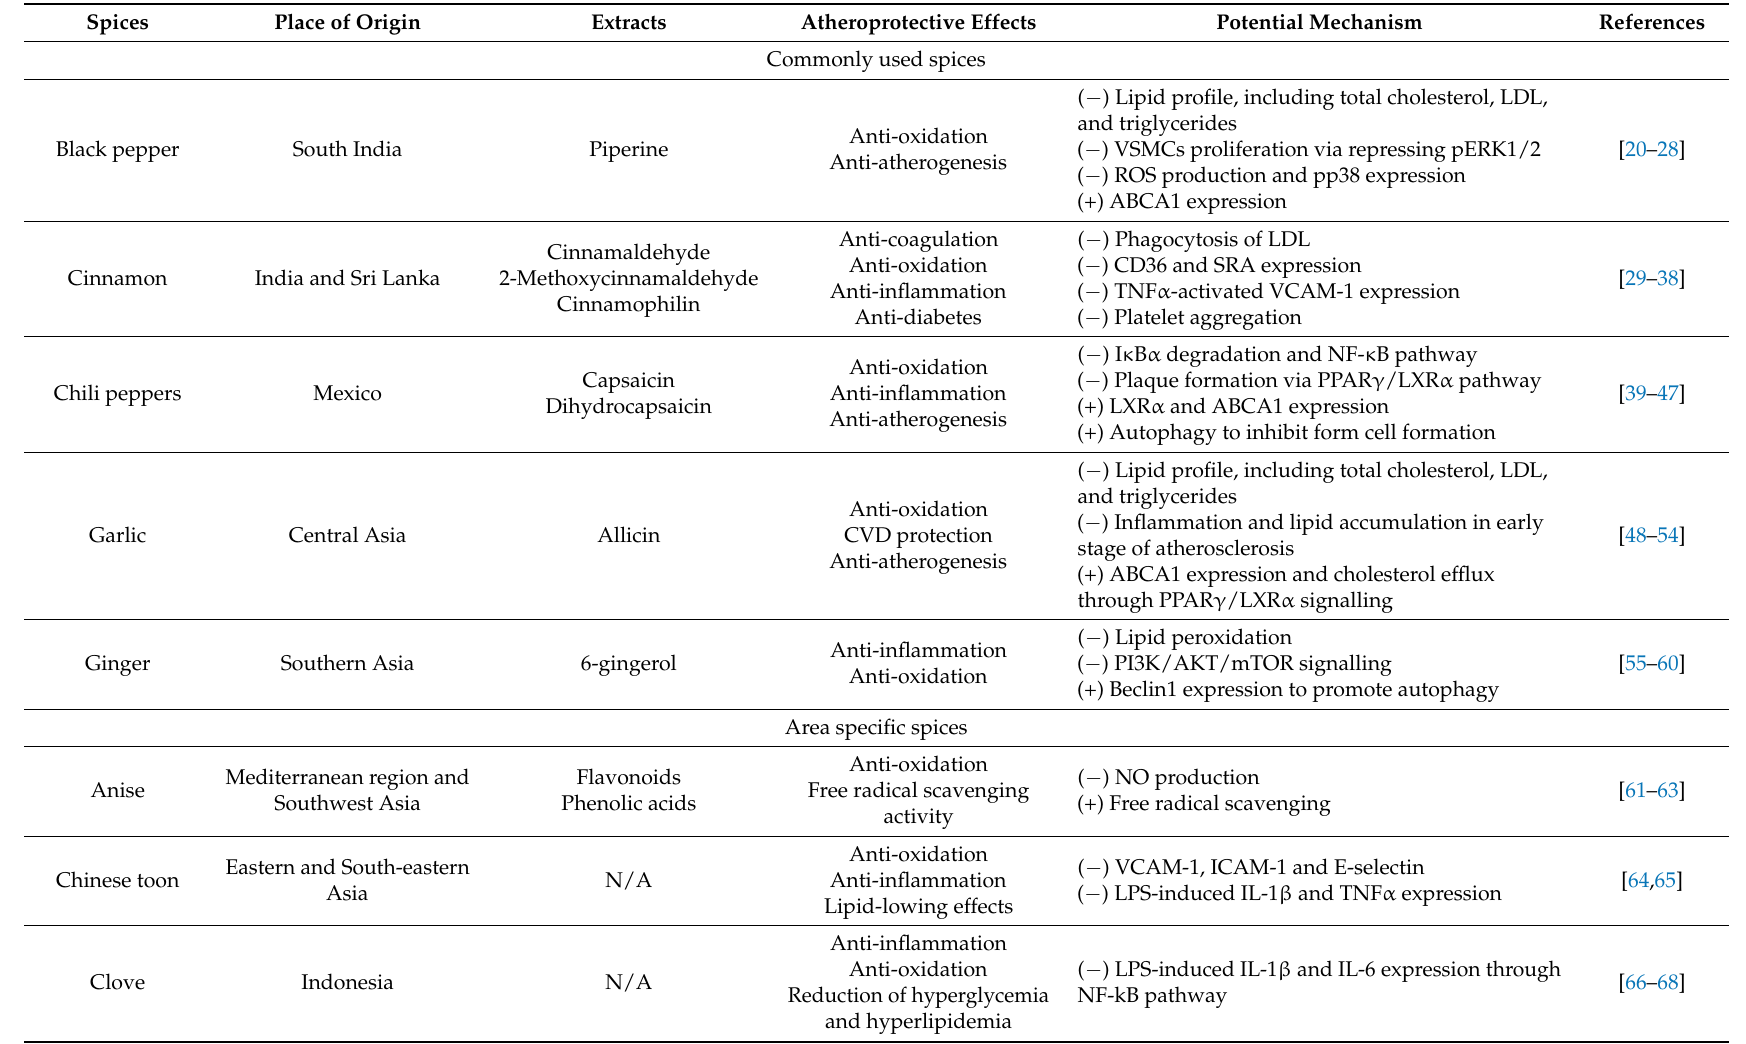
Table 2. Spices and its potential mechanism in atherosclerosis